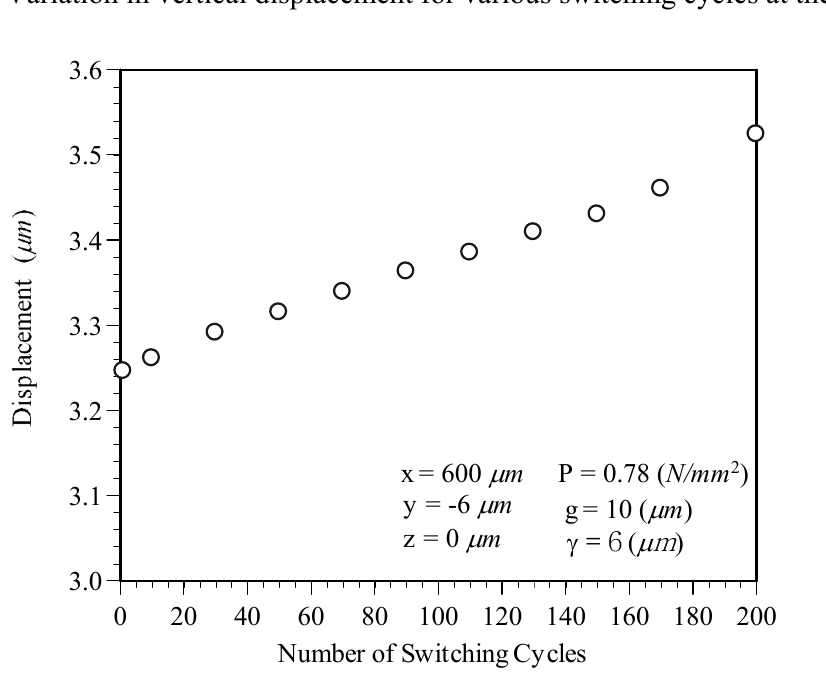
Figure 13. Variation in vertical displacement for various switching cycles at the free end .